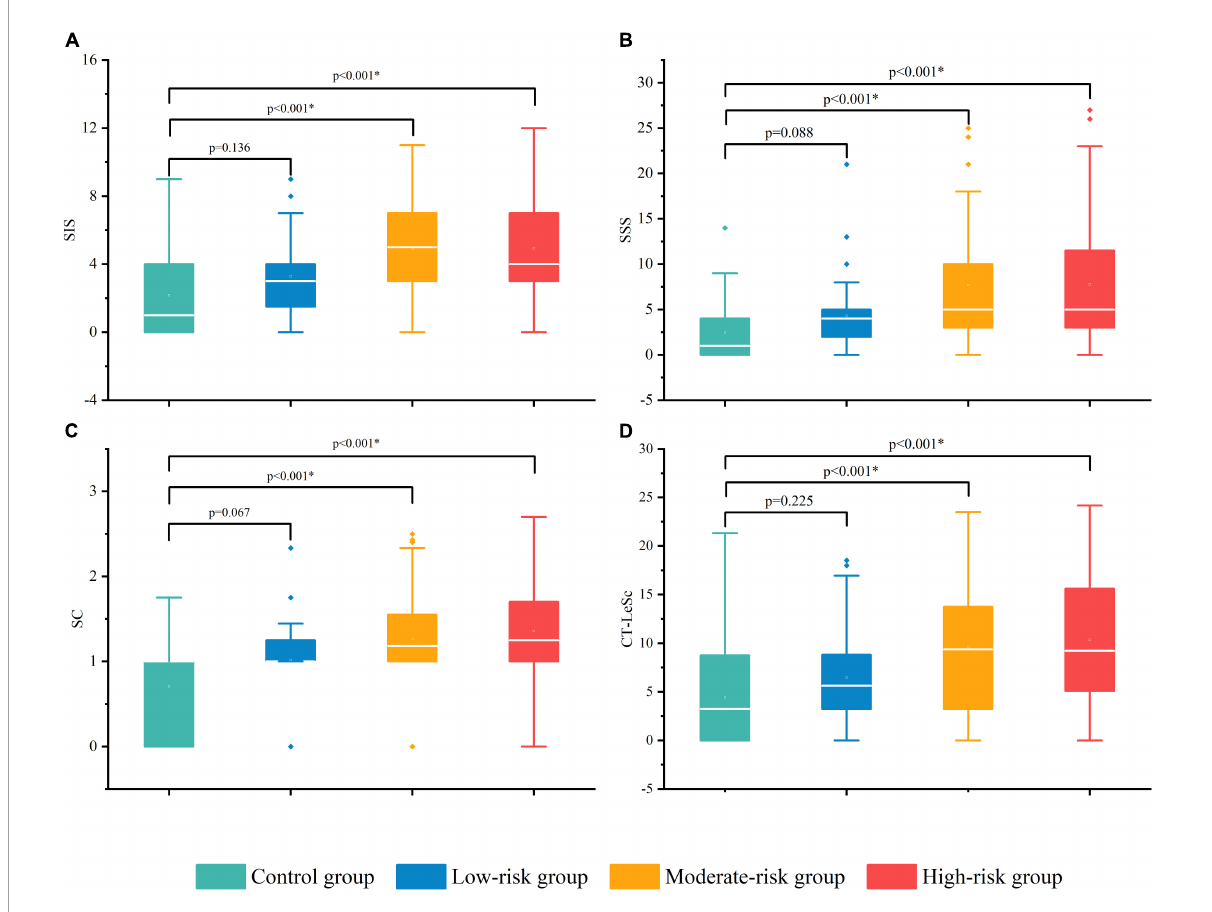
FIGURE4 The difference in the CCTA stenosis scores among the control group and DM subgroups. SIS (A) , SSS (B) , SC (C) , and CT-LeSc (D) . SIS, segment involvement score; SSS, segment stenosis score; SC, stenosis coefficient; CT-LeSc, CCTA-adapted Leaman score. * p -value < 0.05.